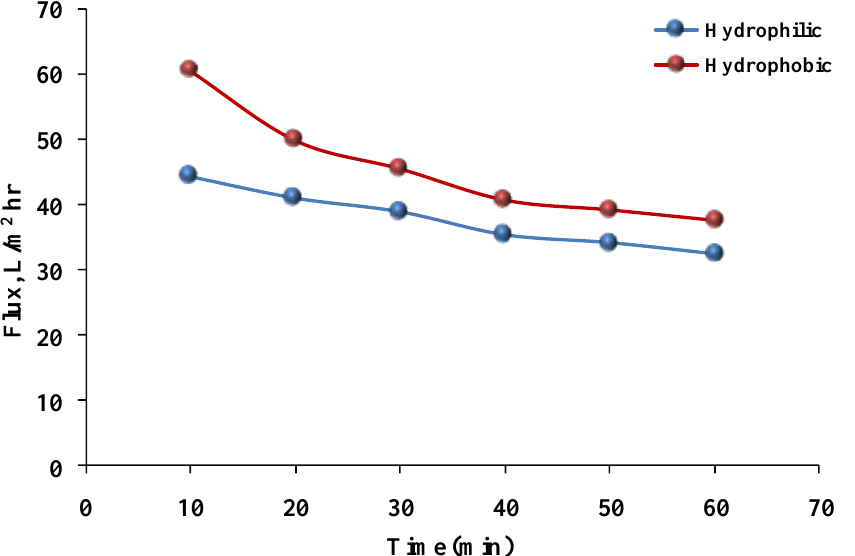
Figure 12. Flux versus time of the phenol solution for hydrophilic and hydrophobic membranes (pressure = 1 bar, temperature = 30 °C, phenol concentration = 50 mg/L).